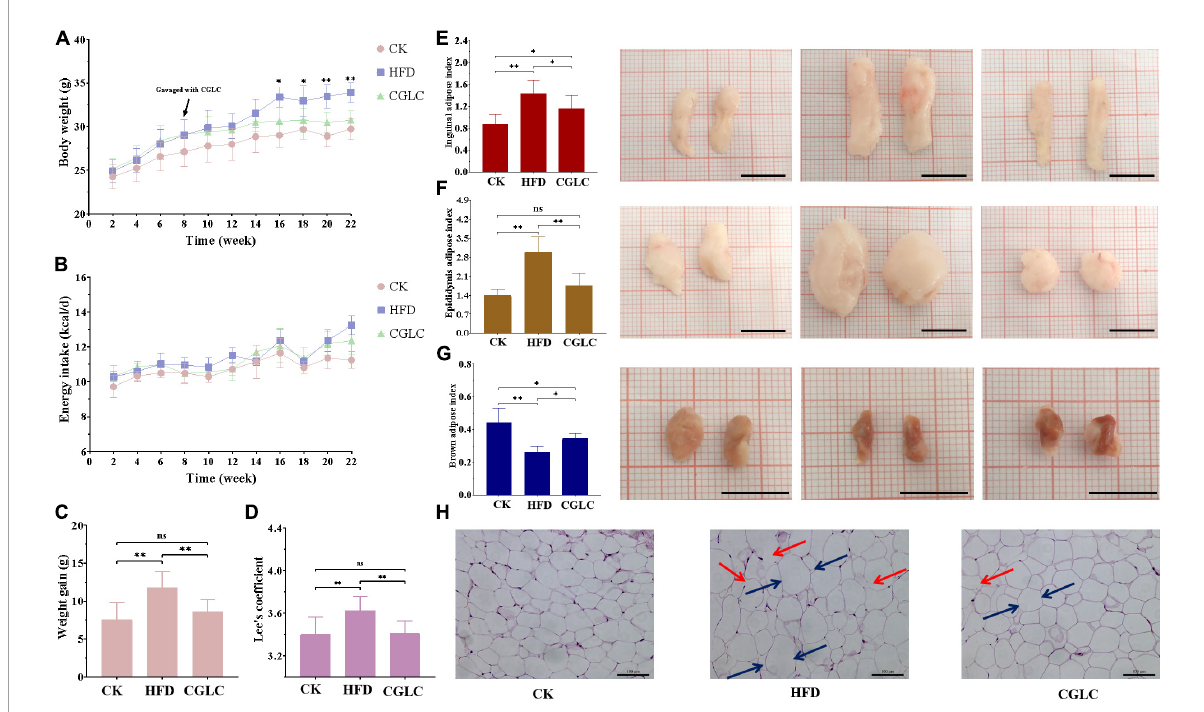
FIGURE1 Effects of CGLC on body weight gain, energy intake, fat accumulation, and characteristics in obese mice induced by HFD. Changes in body weight (A) and average energy intake (B) over 22 weeks. Measurements of body weight gain (C) and Lee’s coefficients (D) . Effects of CGLC on fat indexes and morphological characteristics of inguinal fat (E) , epididymis fat (F) , and brown fat (G) . Effect of CGLC on epididymis adipose cells [scale bar 100 µ m, 200 × (H) ]. ns, no significant difference; ∗ , significant difference ( P < 0.05); ∗∗ , highly significant difference ( P < 0.01); black line, 1 cm; blue arrows, cell diameter; red arrows, cytoplasmic fractures.